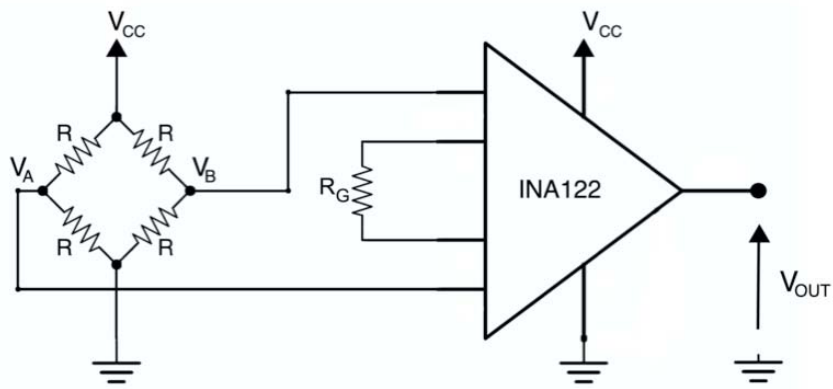
Figure 4. Loadcell conditioning circuit based on an instrumentation amplifier